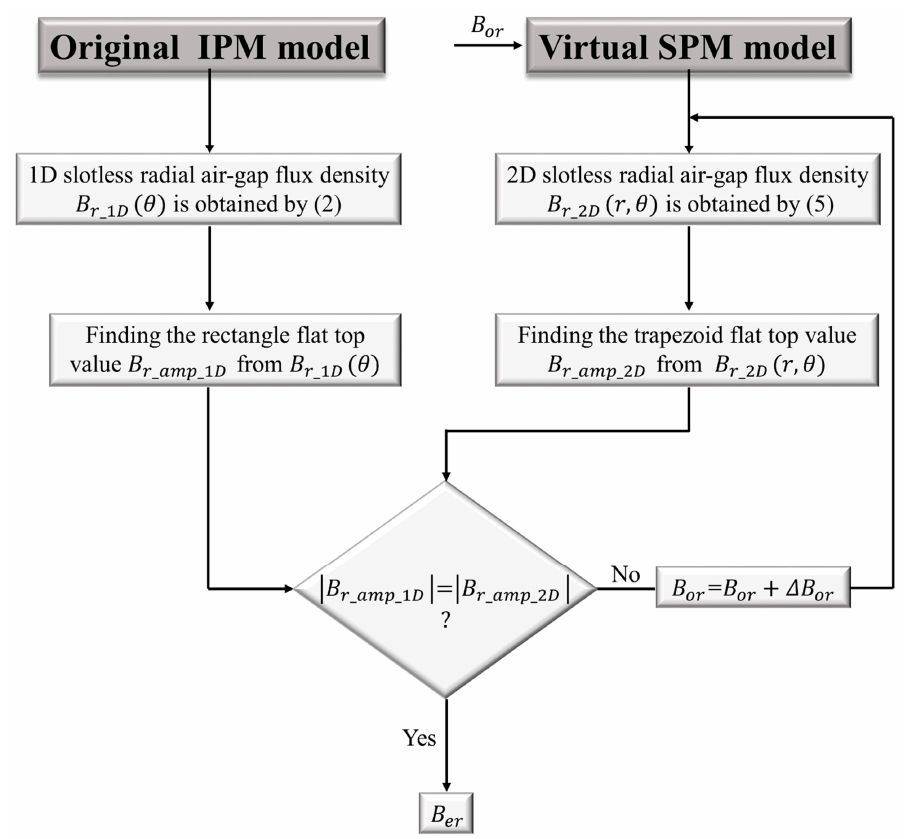
B . Figure 6. The iterative process of obtaining the equivalent magnet remanence B er . er